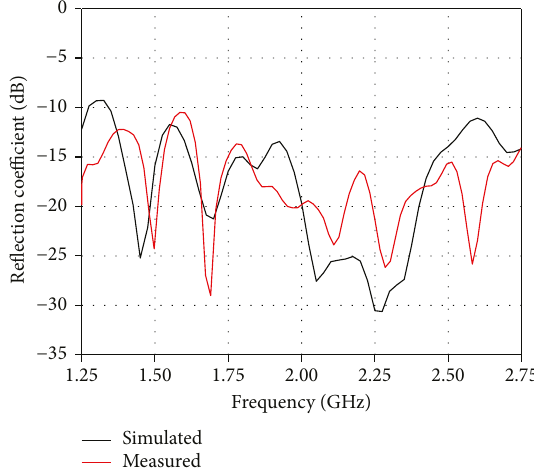
Figure 10: Simulated and measured re fl ection coe ffi cients of the proposed